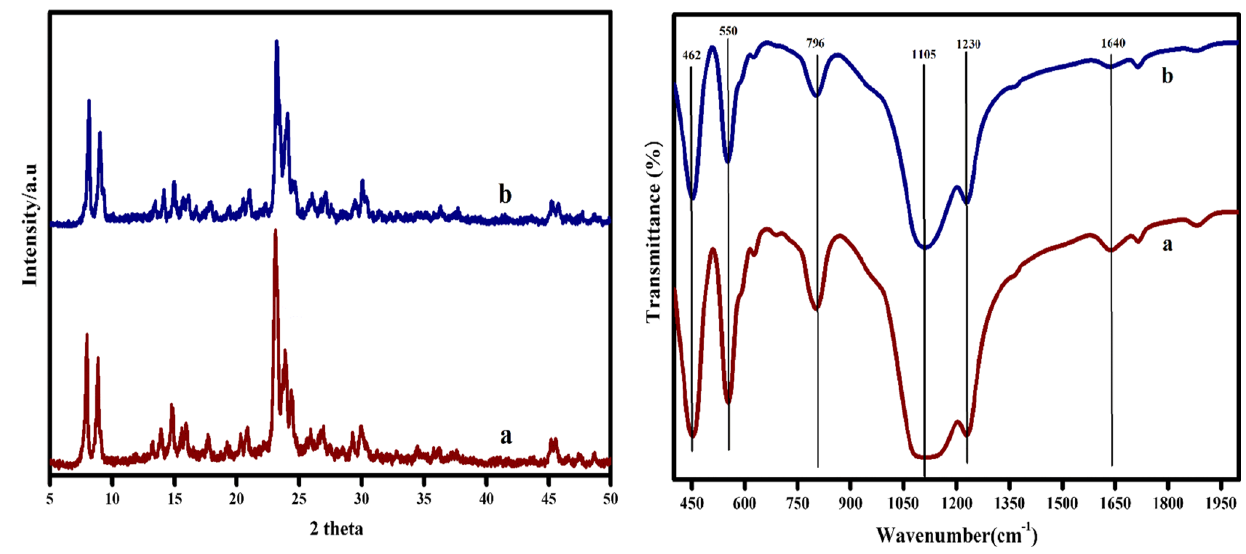
Fig. 2 Powder XRD patterns and FT-IR spectra of conventional and mesoporous